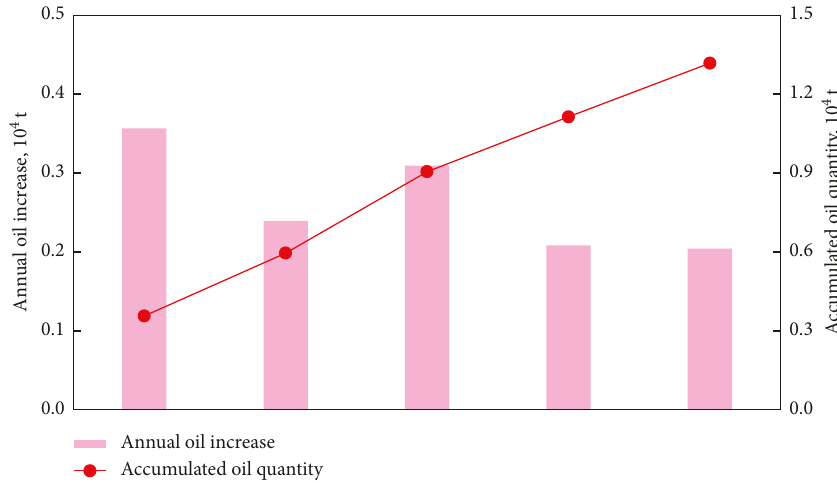
Figure 5: Prediction results of pressure flooding and water injection stimulation effect.